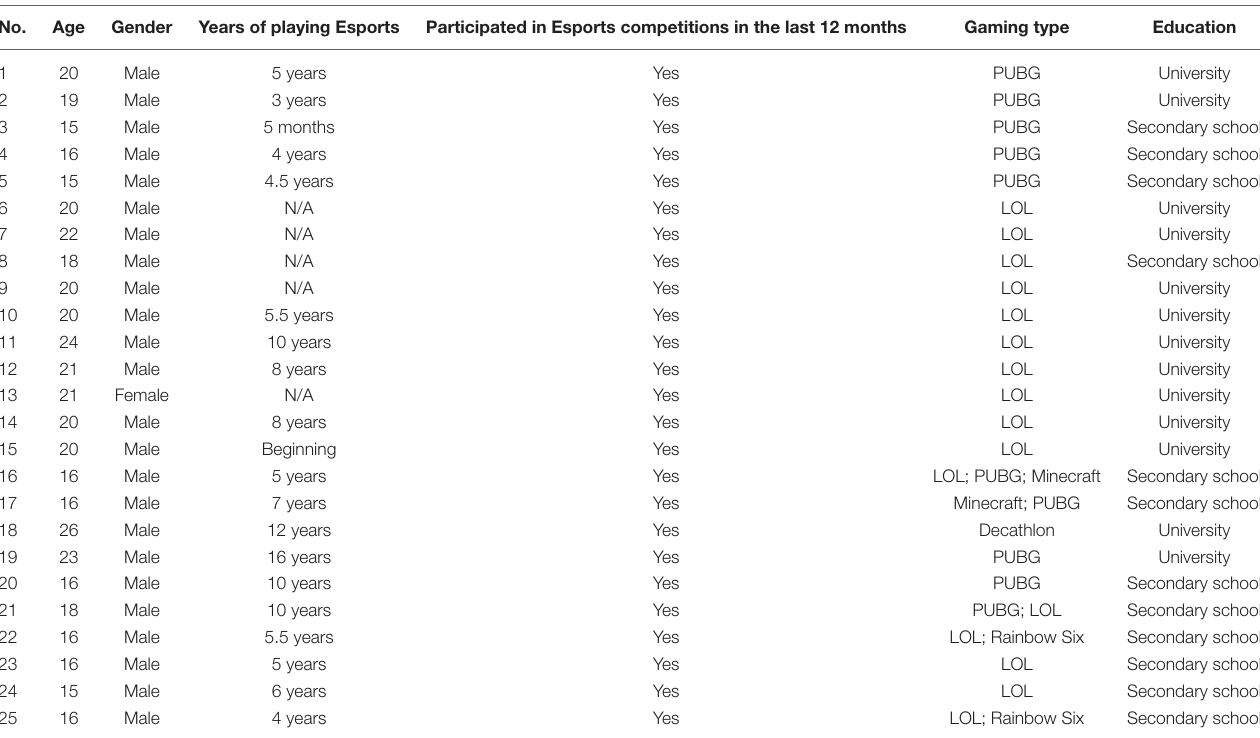
TABLE 1 | Demography of